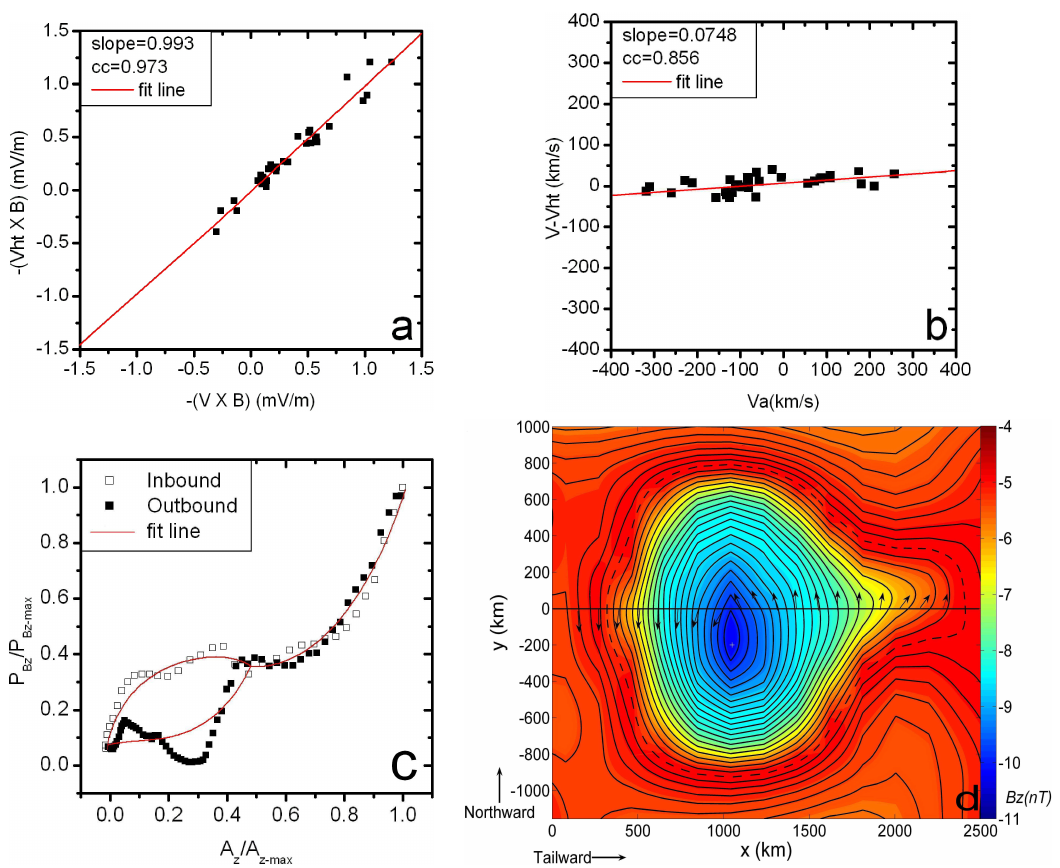
Fig. 2. (a) and (b) The result of deHoffman-Teller analysis. (c) Normalized magnetic pressure P Bz versus normalized A z . (d) The recon- struction results of the flux rope on 5 February